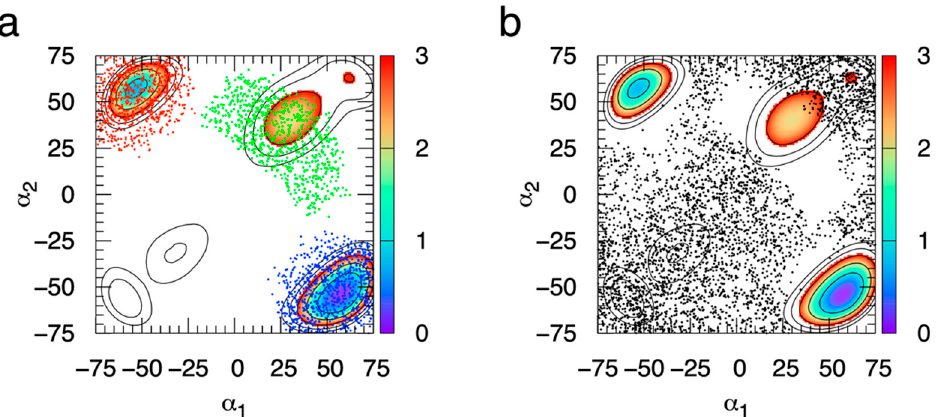
Figure 4. Sampling of specific Me α IdoA ring puckering conformations during eABF simulation with the Babin-Sagui ( α 1 , α 2 ) reaction coordinate. Sampled ( α 1 , α 2 ) values are separated into those for 4 C 1 , 1 C 4 , and 2 S O (blue, red, and green dots, respectively, in panel “a”) and for all other (black dots, panel “b”) puckering conformations. α 1 and α 2 are in degrees. Δ G ( α 1 , α 2 ) is in kcal/mol, with contours drawn every 1 kcal/mol from 0–5 kcal/mol and colored from 0–3 kcal/mol. Puckering data have been aggregated across the triplicate simulations, and Δ G ( α 1 , α 2 ) is from the first simulation in the triplicate.